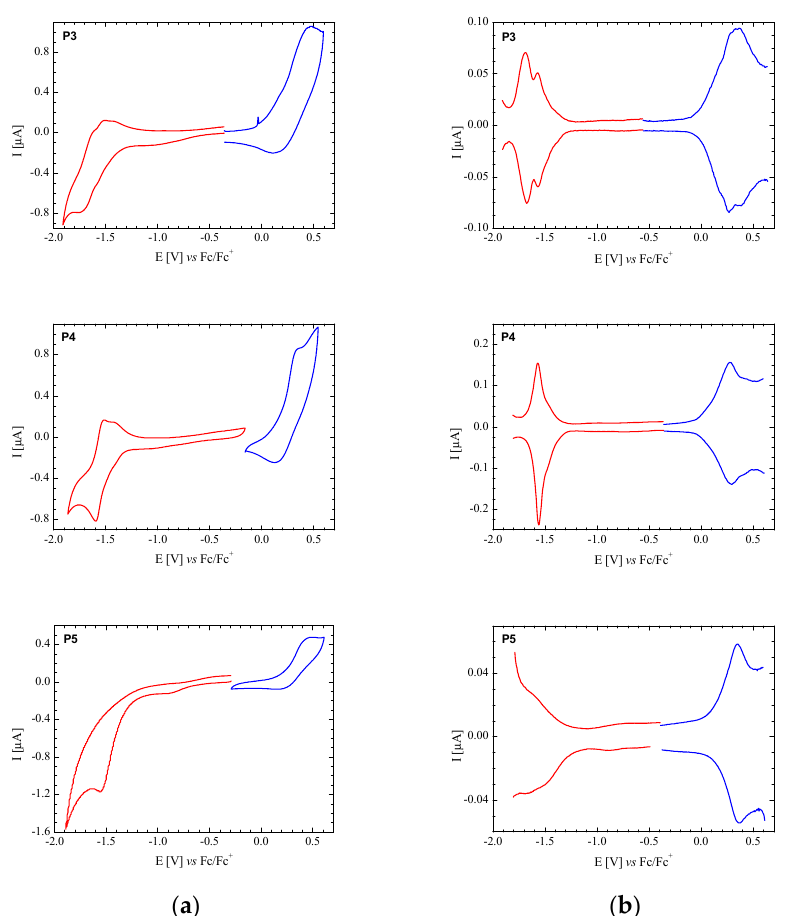
Figure 3. Cyclic voltammograms ( a ) and differential pulse voltammograms ( b ) registered for the polymers P1 – P5 dissolved in 0.1 M Bu 4 NBF 4 /dichloromethane electrolyte. CV: scan rate = 50 mV/s and DPV: modulation time = 50 ms, modulation amplitude = 10 mV, step potential = 5 mV. Table 2. Electrochemical properties of polymers P1 – P5 . Data presented: oxidation and reduction potentials vs. Fc/Fc + ; ionization potential, IP; electron affinity, EA; electrochemical band gap, E gCV ; exciton binding energy, E b .